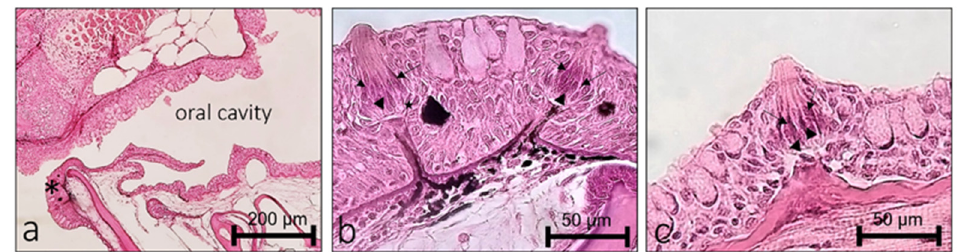
Figure 5. Light micrographs (hematoxylin/eosin staining) of adult zebrafish taste buds, dorsal view. ( a ) Oral cavity with taste buds, taste buds of the lips (*). ( a , b )Taste buds showing light cells (arrowhead) add dark cells (arrow); ( b ) Merkel-like basal cells (star). Scale bar ( a ) 200 µm and ( b , c ) 50 µm.